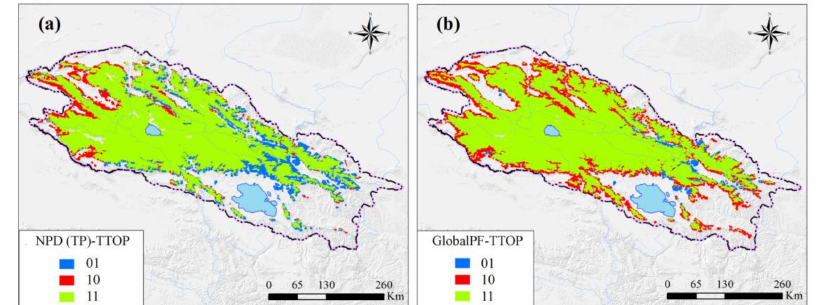
Figure 3. Comparisons of calculated permafrost extent to the published permafrost maps of NPD (TP) ( a ) and GlobalPF ( b ) in the Qilian Mountains. NPD (TP) indicates the permafrost map compiled by Zou et al., 2017; GlobalPF indicates the permafrost map compiled by Obu et al., 2019; and TTOP indicates the permafrost map compiled in this study. 0 and 1 represent permafrost and no permafrost, respectively. The first and second numeric numbers indicate published permafrost maps and the calculated results in this study, respectively.